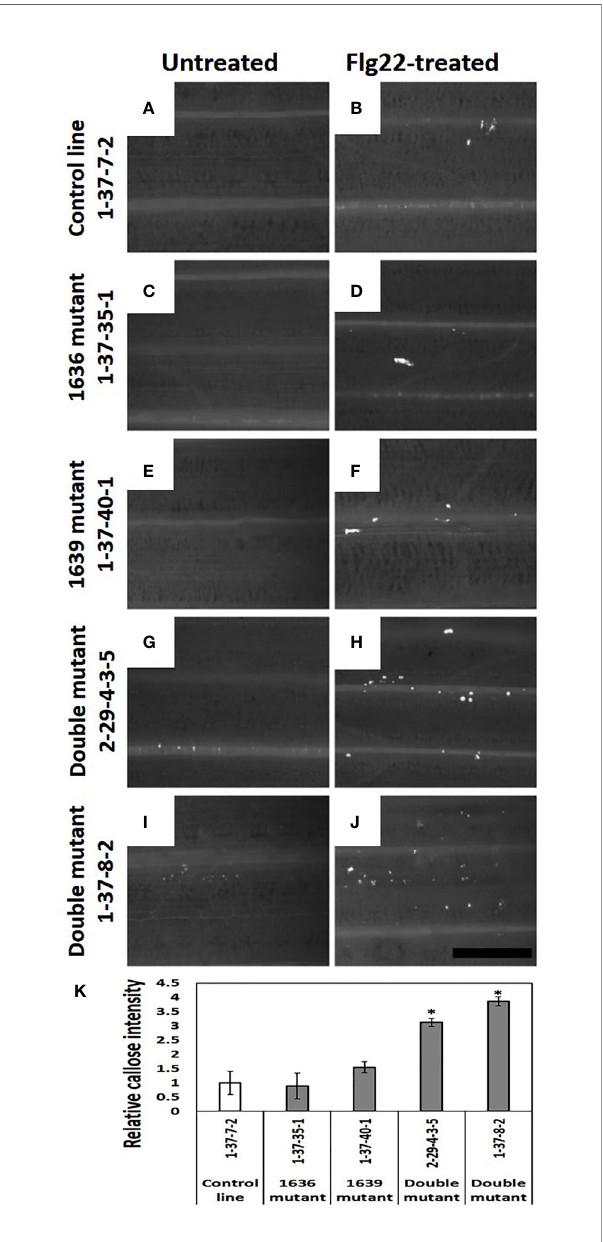
FIGURE 8 | Callose deposition (white spots in the images) in barley leaves of 2 weeks old seedlings, without (A, C, E, G, I) and with Flg22 treatment (B, D, F, H, J) . Callose was stained with aniline blue. a and b=control line 1-37-7-2, c and d=1636 mutant line 1-37-35-1, e and f=1639 mutant line 1-37-40-1, g and h=double mutant line 2-29-4-3-5, and i and j=double mutant line 1-37-8- 2. Scale bar 500 m m. (K) Number of pixels corresponding to the color of callose in Flg22-treated leaves of mutant lines relative to that of a control line (mean ± SE, n=4). The data was analyzed by one-way ANOVA (see Table S1 ), followed by LSD test at p =0.05. * above the bar indicate signi fi cant differences between the mutant and the control